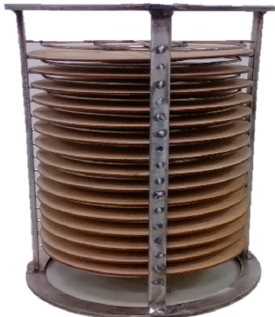
Figure 1. Cellulose pressboard disc specimens used in our experiments.